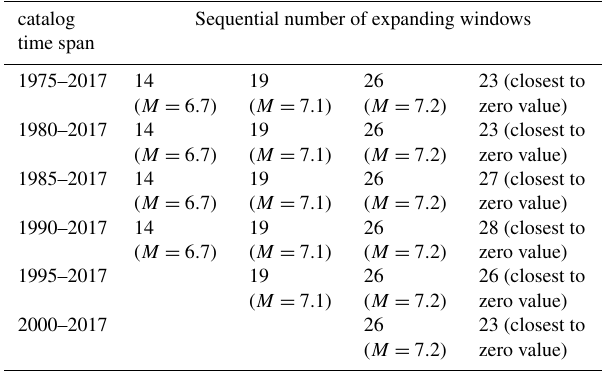
Table 3. Comparison between expanding by 10 data windows with the strongest earthquakes occurrences and windows with IDT val- ues closest to zero. Representative threshold M = 4 . 6.